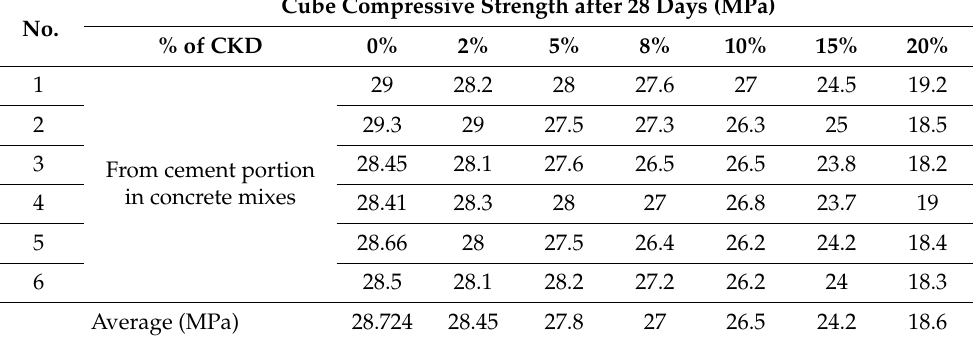
Table 3. Concrete sample compressive strength